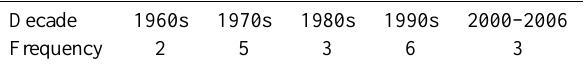
Figure 2. (a) Nitrate concentration record from the shallow ice core; (b–d) show seasonal peaks of NO − two sections of the ice core (data shown in b, c and d are 3-point running averages). Vertical dashed lines in (a) indicate the years of snowfall at relevant depths.